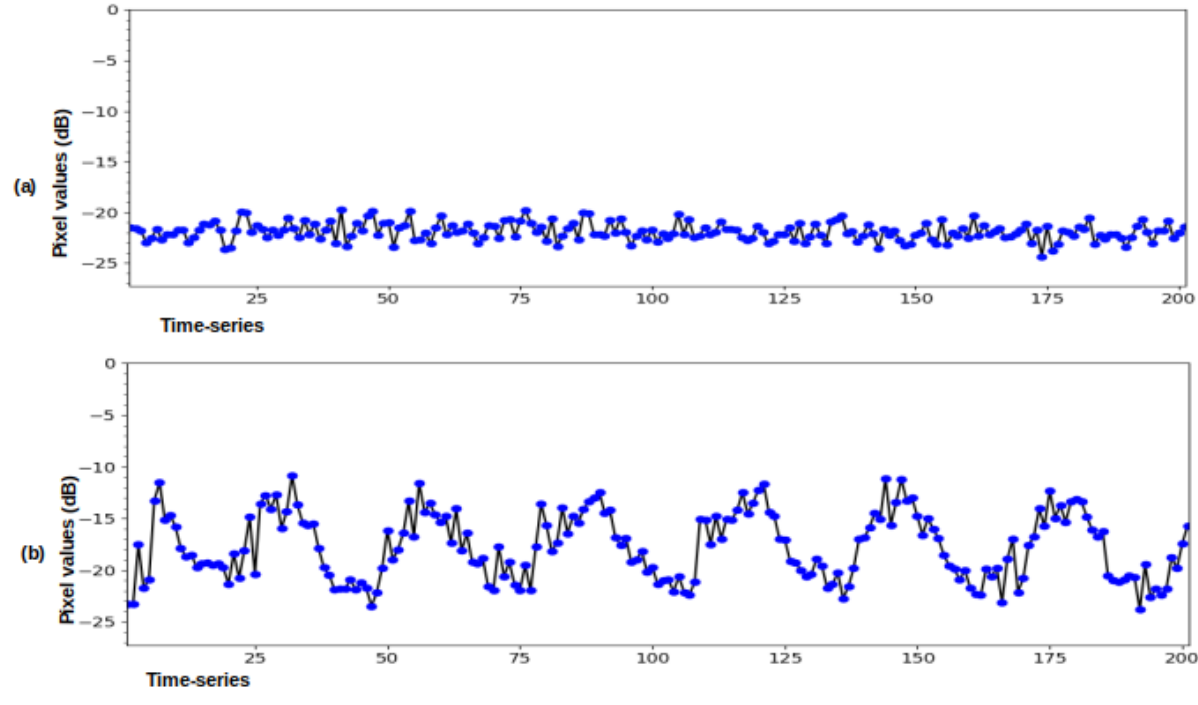
Figure 12. Temporal profile of pixels belonging to two soil types in the BNP image time series. The pixel values of the VH-band images are in dB and vary with the dates in the time series: ( a ) profile of the pixel with coordinates (444981, 956504) in a water surface; ( b ) profile of the pixel with coordinates (448858, 972155) in an agricultural